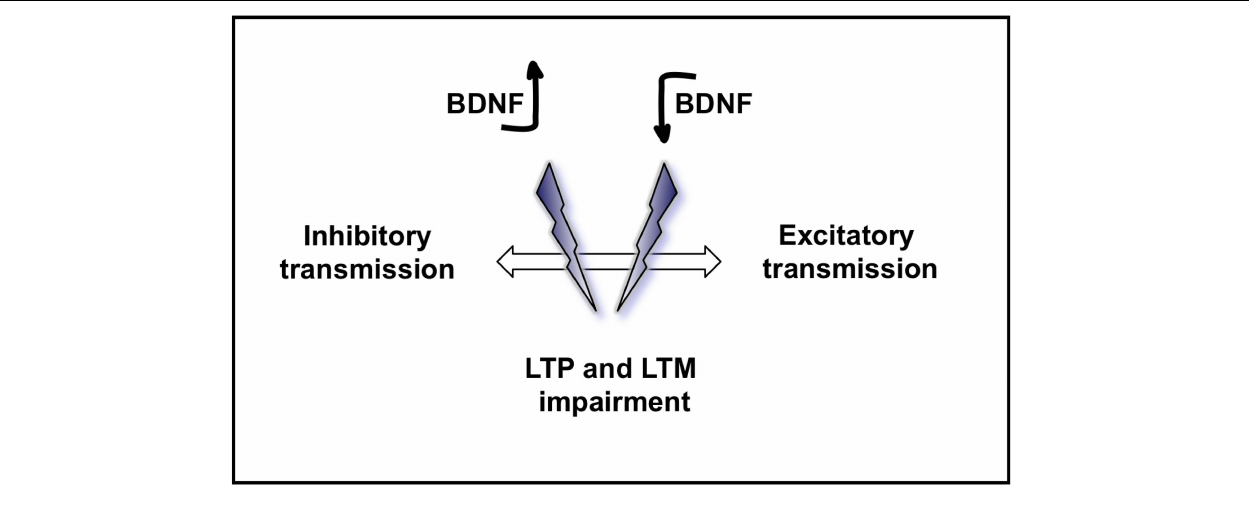
FIGURE 5 | Model proposed for the role of BDNF on excitatory and inhibitory circuits in the brain and its consequences on LTP and LTM. While a physiological amount of BDNF in the normal brain has been demonstrated to have positive effects on learning and memory, both an